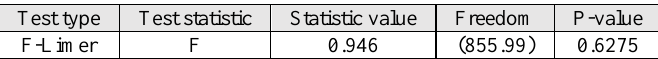
Table 5: Results of F-Limer Test for model